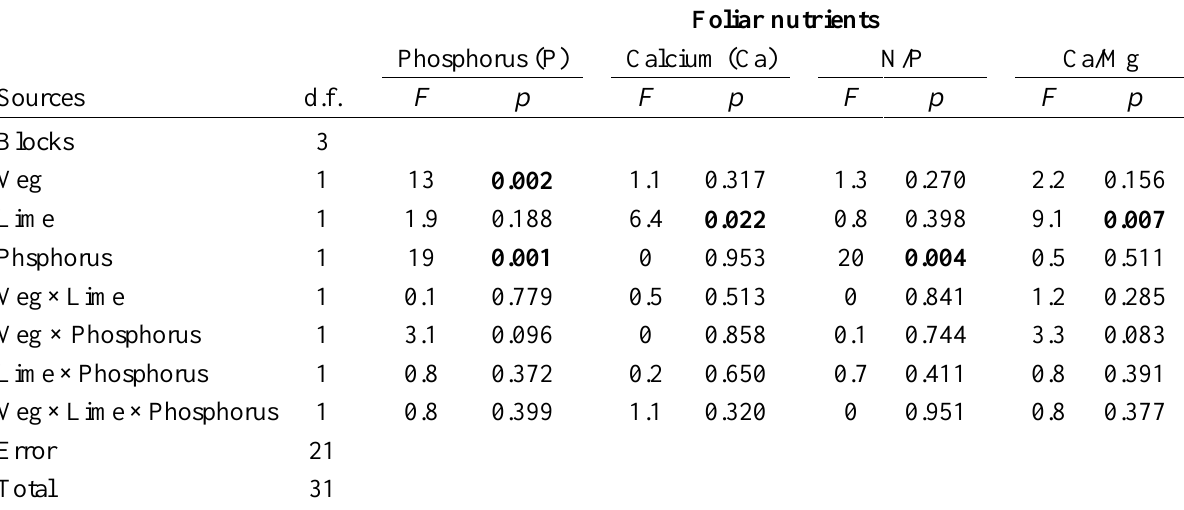
Table A3. Results of ANOVA testing for amendments and introduced plant material effects on leaf nutrient status in the field experiment. Foliar nutrients were analysed only in transplanted C. paleacea and S. pectinata , not in the other three vegetation treatments. Significant p values are shown in bold type ( n = 40).